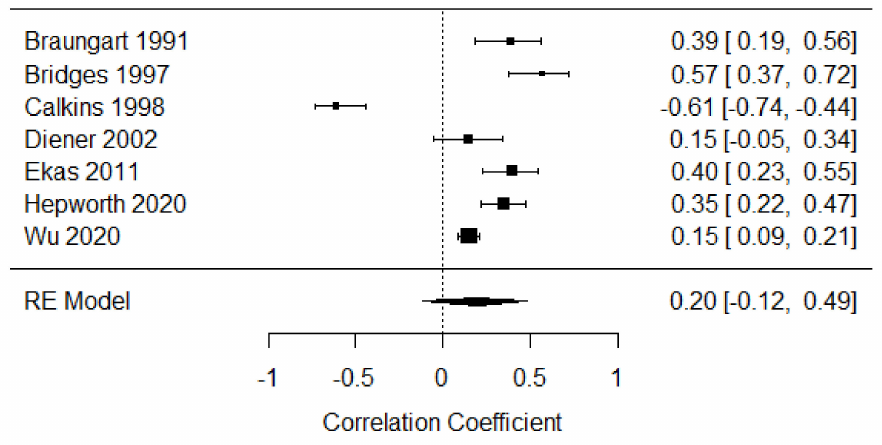
Figure 7. Forest plot of year 2 parent-focused strategies. Note: RE = Random-Effects Model. Third Year of Life